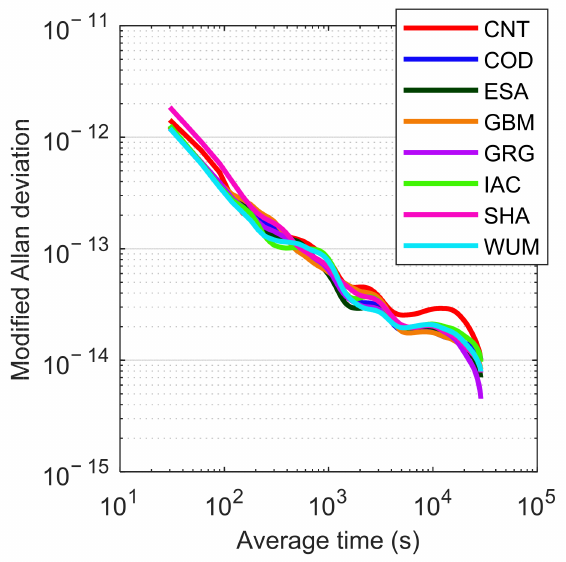
Figure 12. MDEV of the time link BRUX-KOKB derived with eight different precise products on DOY 248,